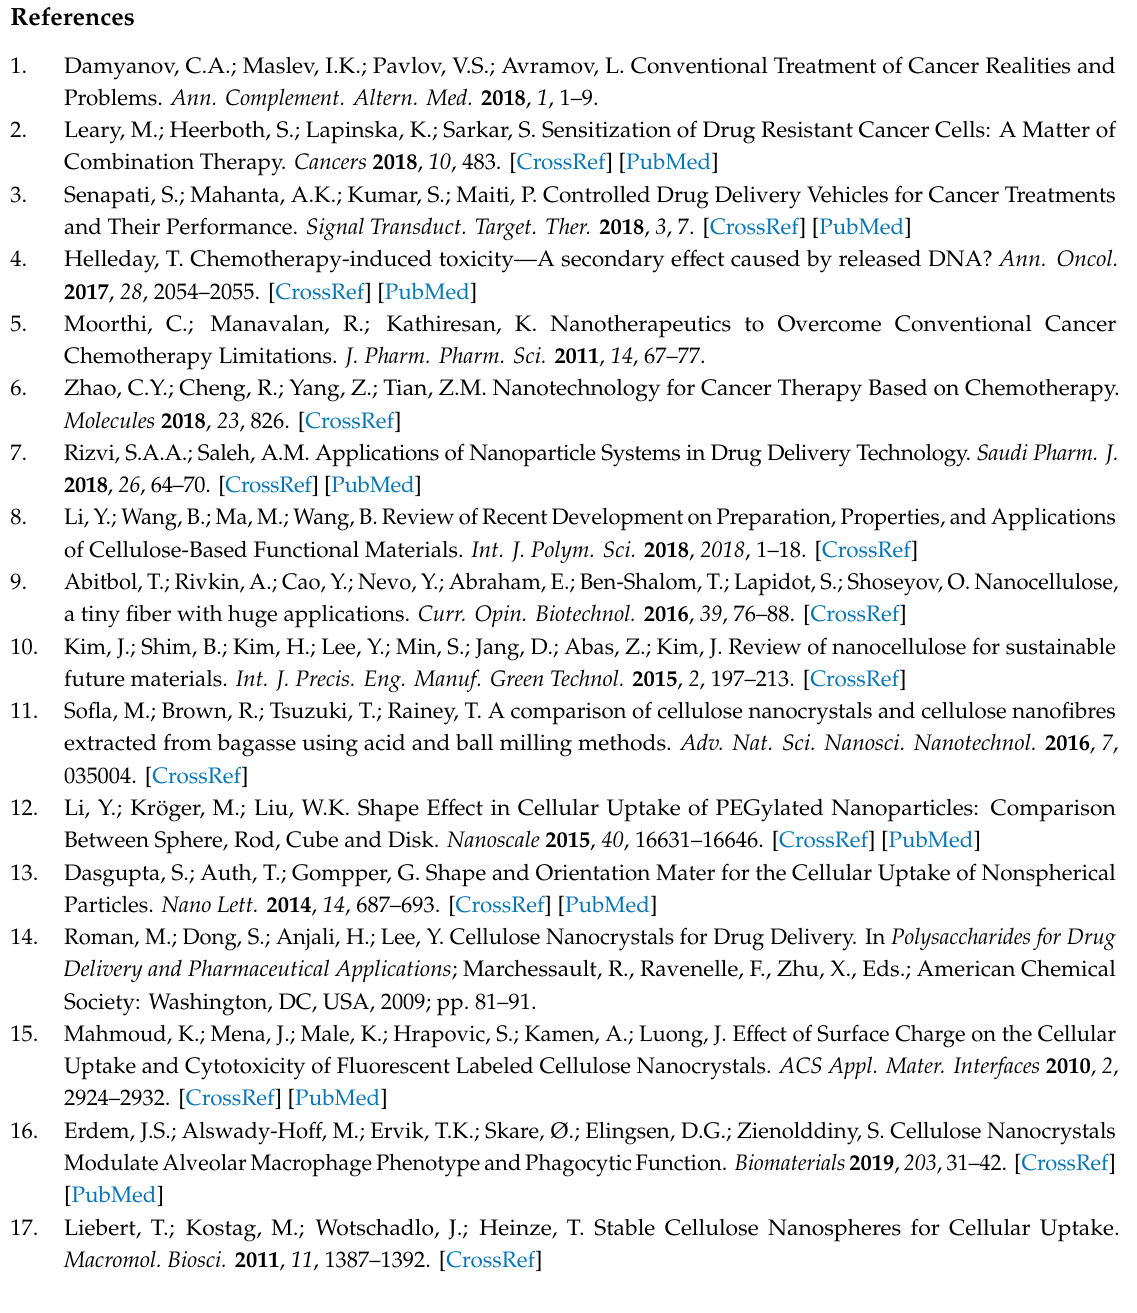
Figure S1: (a) AFM micrograph showing the co-existence of ribbon-shaped and spherical CNC. Histograms of (b) ribbon-shaped CNC length and (c) ribbon-shaped CNC diameter and their respective